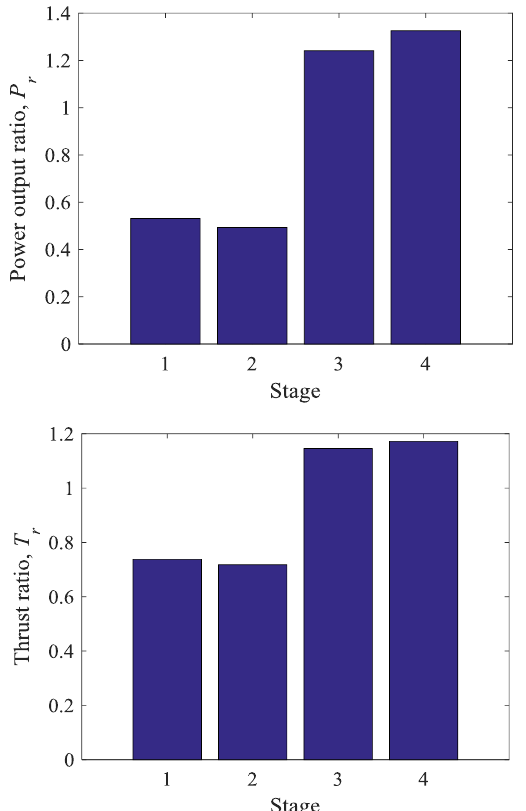
Fig. 6. Power output ratio and thrust ratio of the four stages of the surging turbine oscillating at 𝐴 0 = 0.5m and 𝜔 0 = 0.88 rad/s.